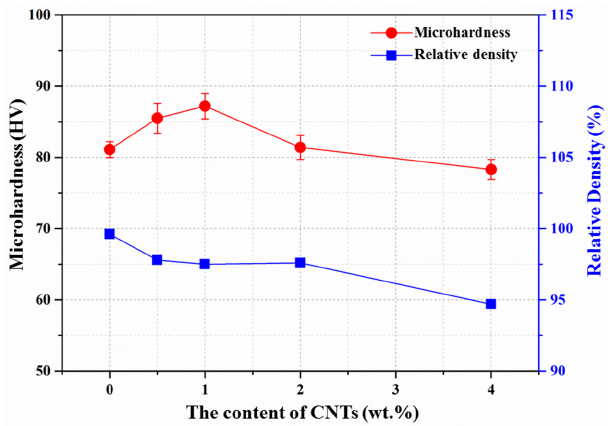
Figure 6. Curves of microhardness and relative density with the addition of varying amounts of CNTs.